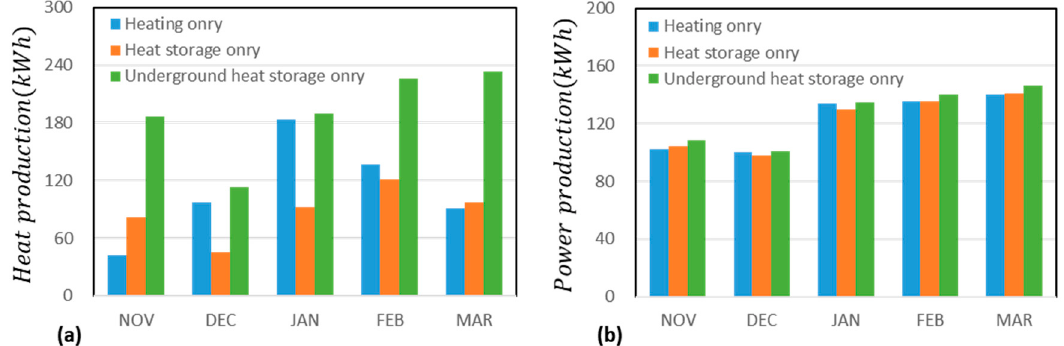
Figure 34. Conceptional designs considering connection method of PVT module. ( a ) Heat production to underground heat storage; ( b ) to hot water; ( c ) to space heating.